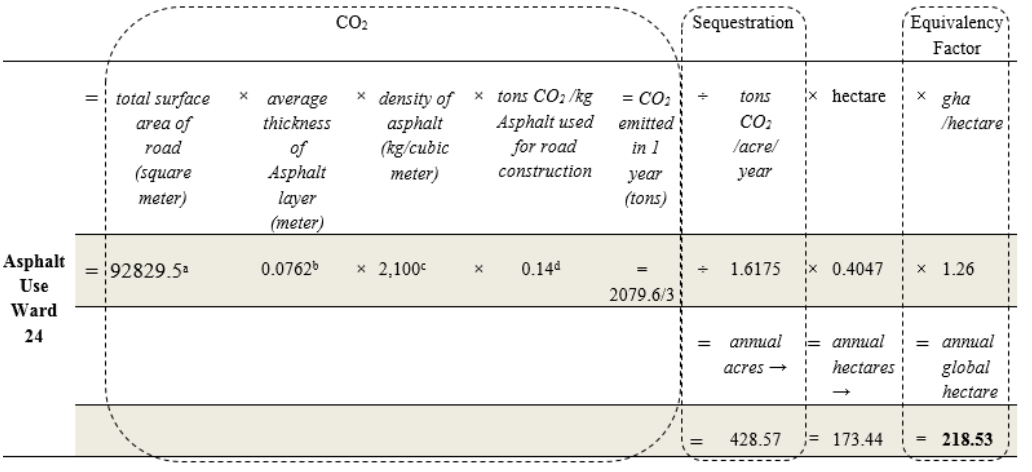
Figure 9. Asphalt consumption footprint calculation and derivation. Source: a [62] b [63] c,d [61].